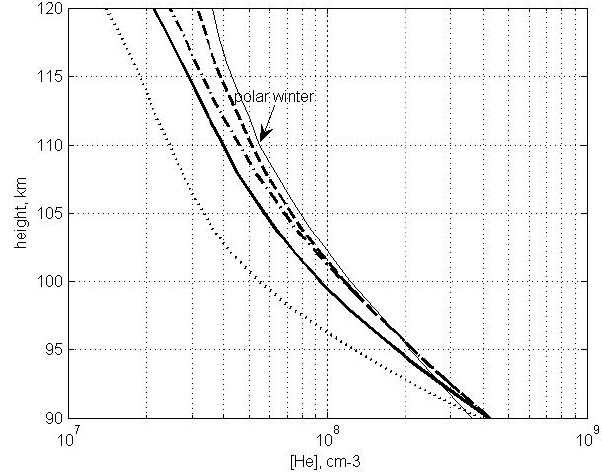
Fig. 2. Height profile of the [Ar]/[N 2 ] ratio in summer solstice at a latitude of 40 ◦ N at 14:00LT, given by the MSIS-E-90 model.